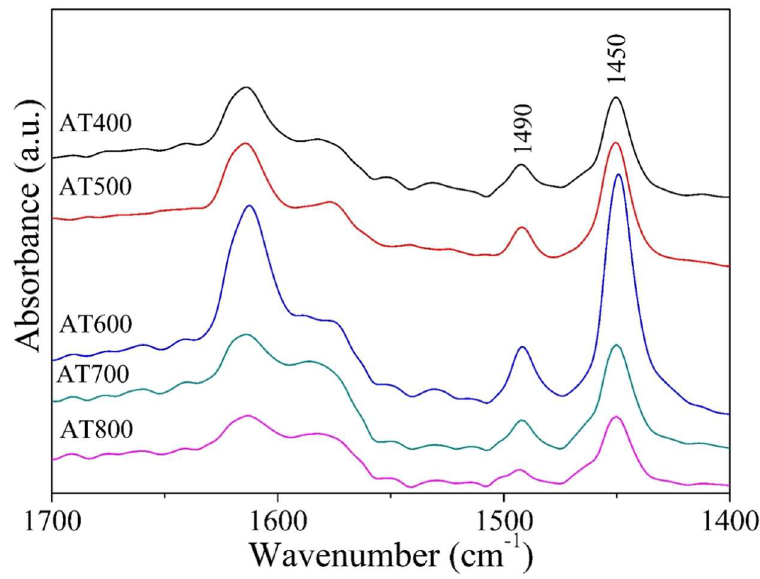
Figure 5. DR-FTIR spectra for adsorption of pyridine for the AT series in the spectral region of 1700–1400 cm − 1 .